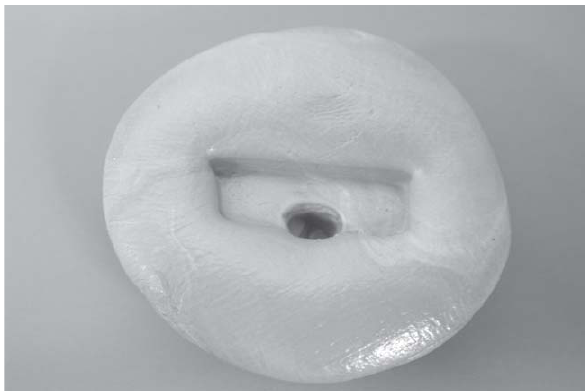
FIGURE 2- Coronal portion of template of addition